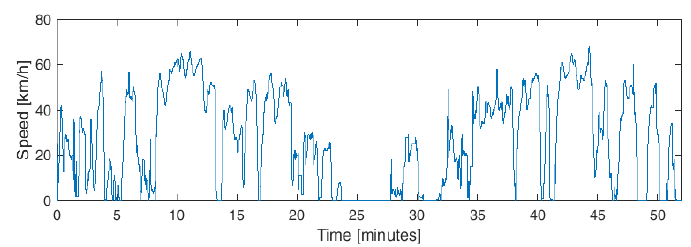
Figure 11. Altitude profile, fast-urban.